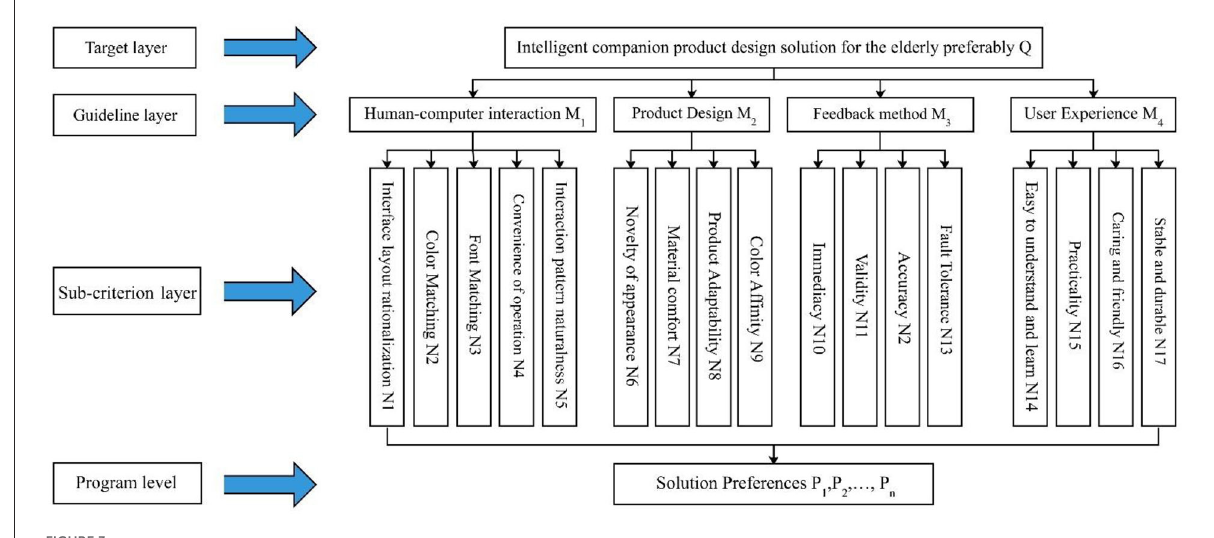
FIGURE3 Evaluation hierarchy model of intelligent companionship products for the elderly.